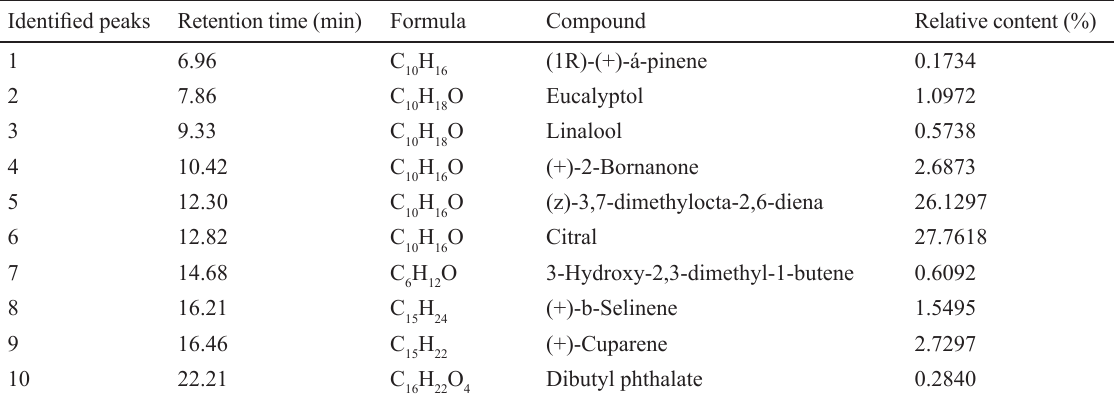
Table 1 . Chemical compositions of Litsea cubeba oil.